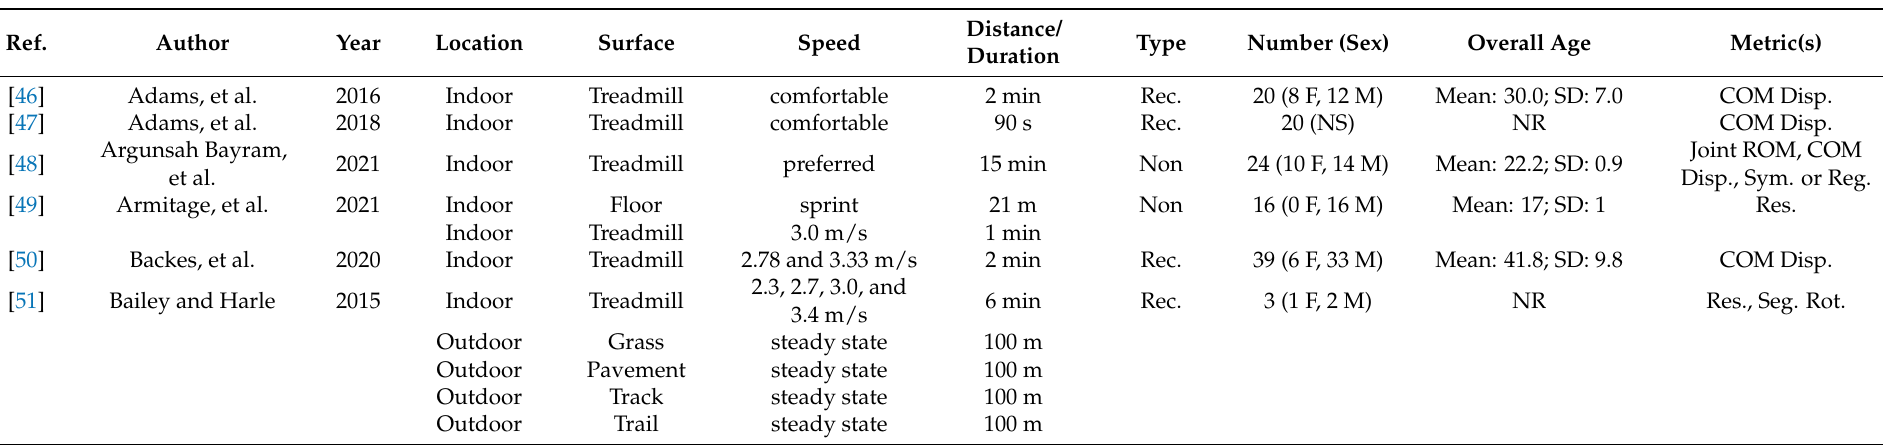
Table 2. Study characteristics where the analyzed distance is <200